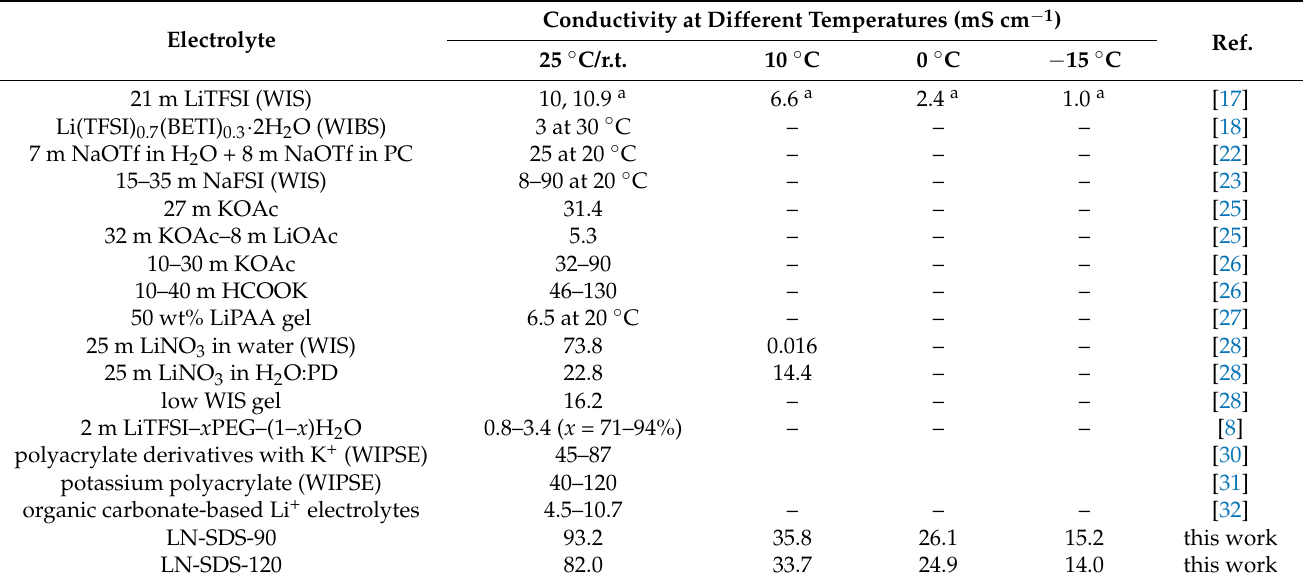
Table 1. Comparison of ionic conductivity for LN-SDS-90 and concentrated electrolytes in the literature. Conductivity at Different Temperatures (mS cm − 1 Electrolyte